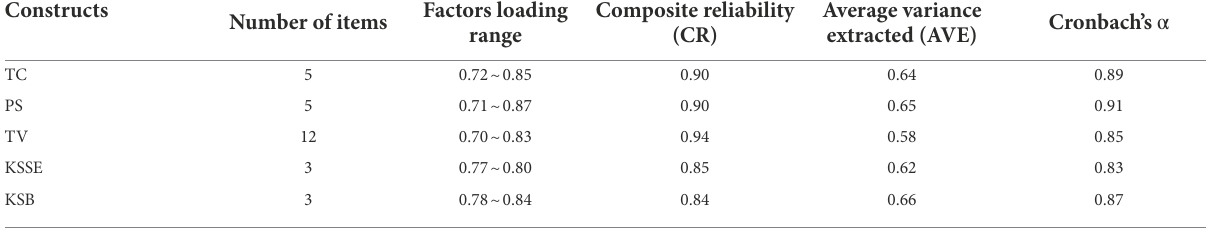
TABLE 1 Convergent validity and reliability